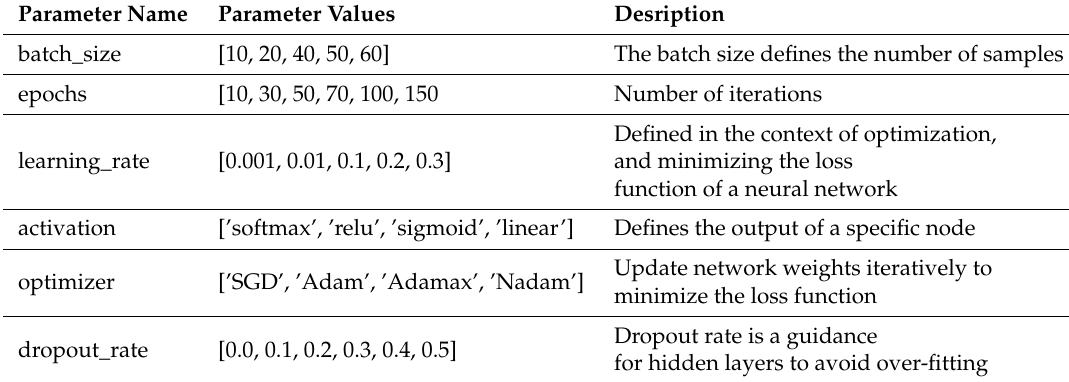
Table 4. Subset of ECNN Parameters for